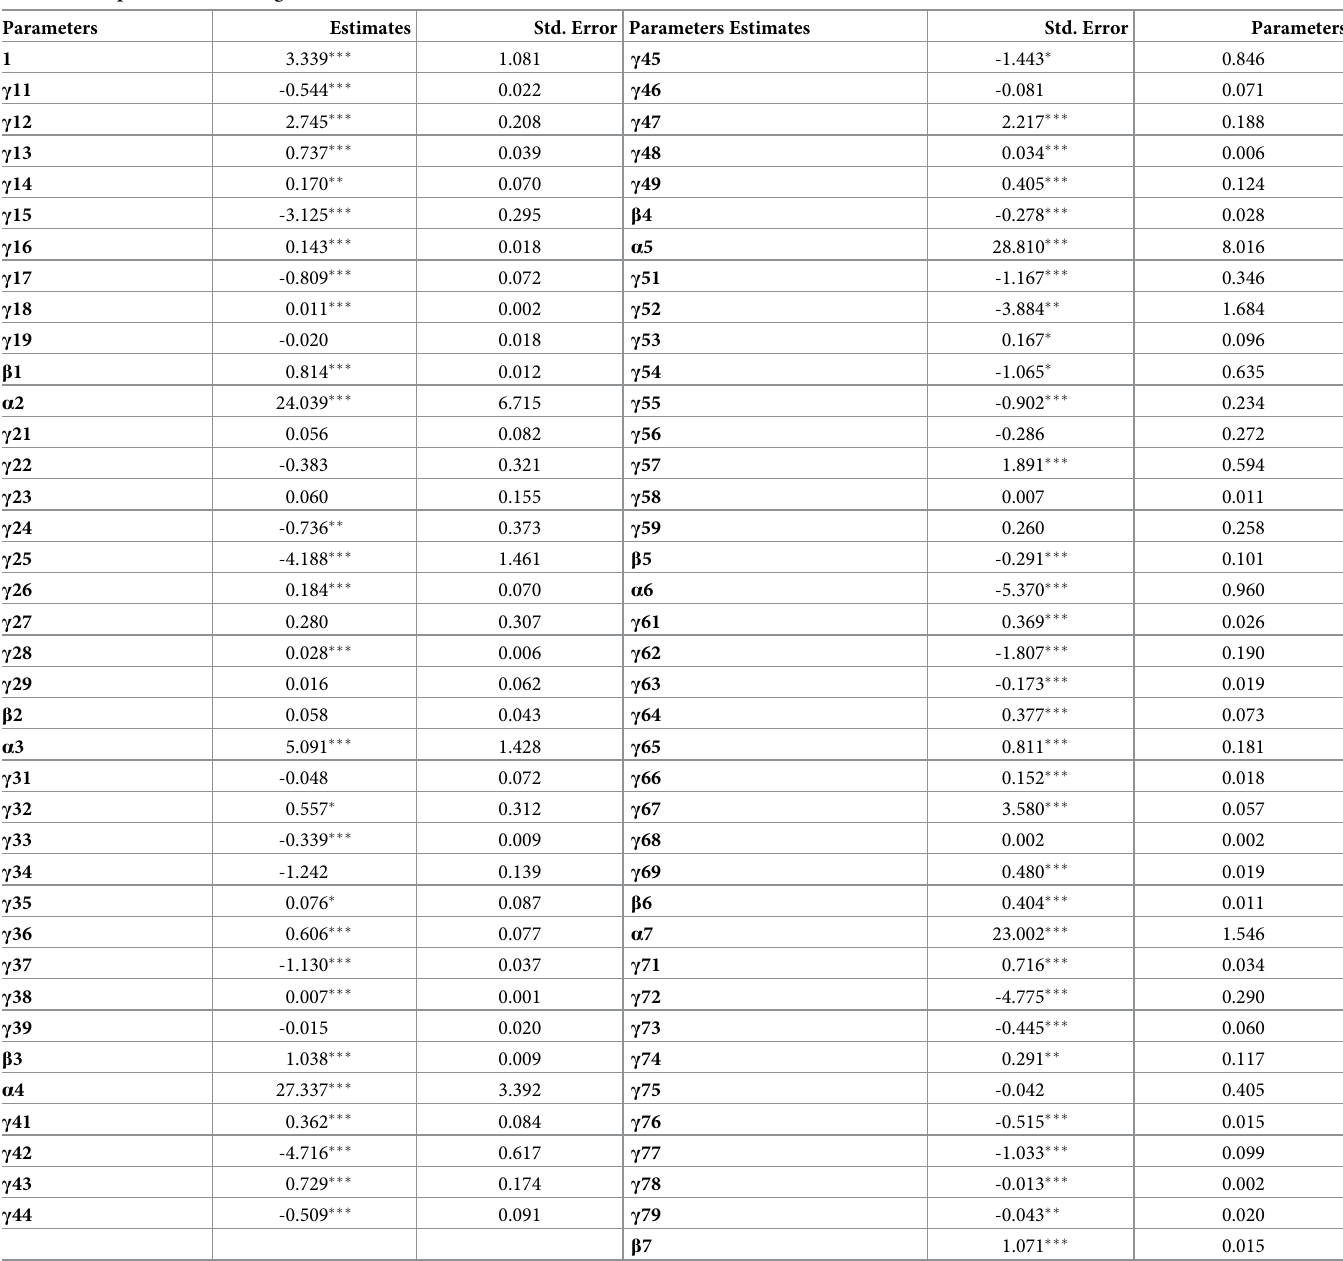
Table 3. Compensated double-log demand